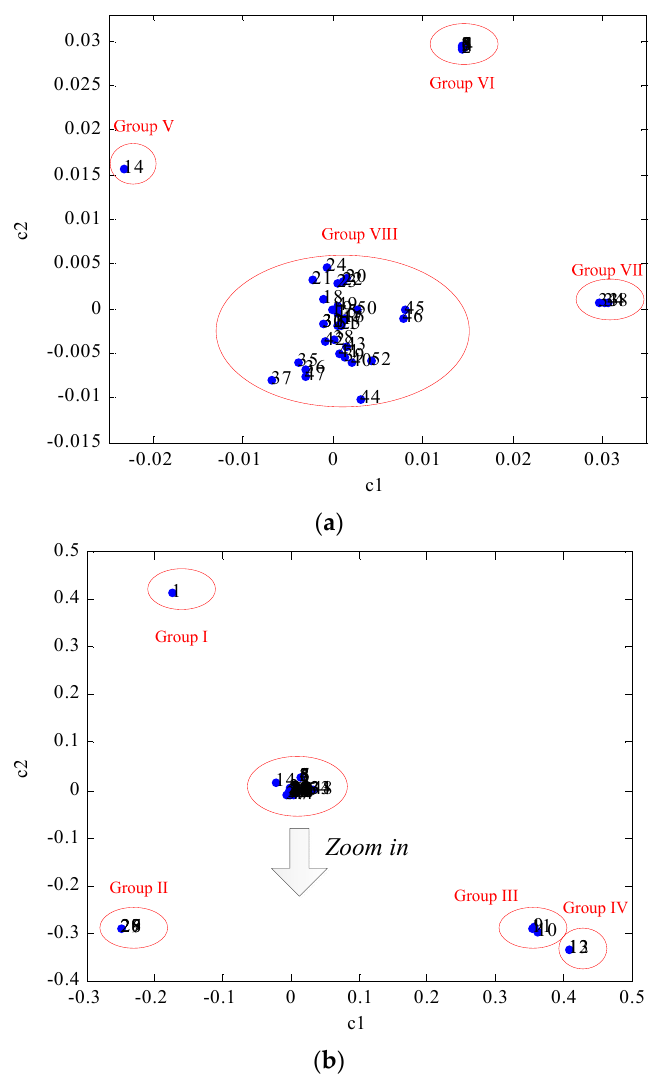
Figure 8. Loadings plot of the PARAFAC model for the sensor mode ( c 1 versus . c 2): ( a ) Loadings plot of the PARAFAC model for sensor mode; ( b ) An enlarged view of the central cluster of ( a ) , c 1 and c 2 are the first two columns of the loading matrix C . Table 1. The eight groups of the sensors.